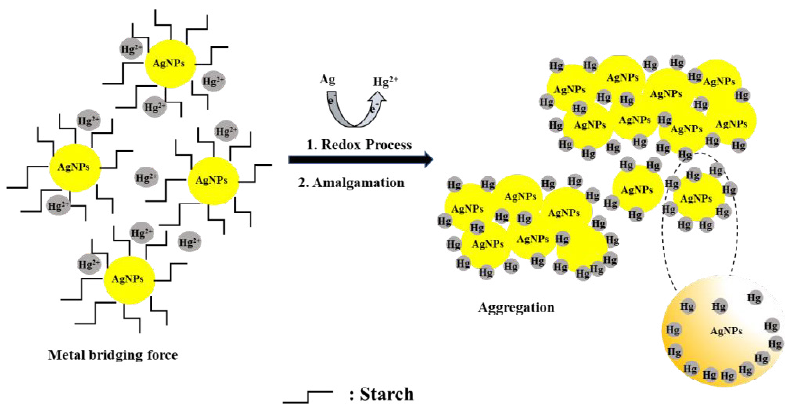
Fig. 15. The proposed mechanism for the interaction between starches coated AgNPs and Hg 2+